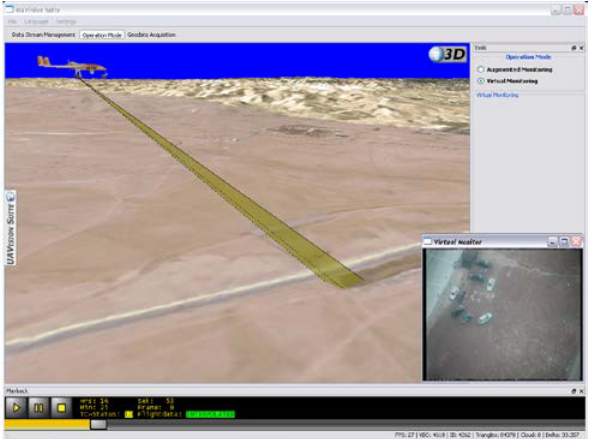
Figure 6: Virtual Monitoring – video integration